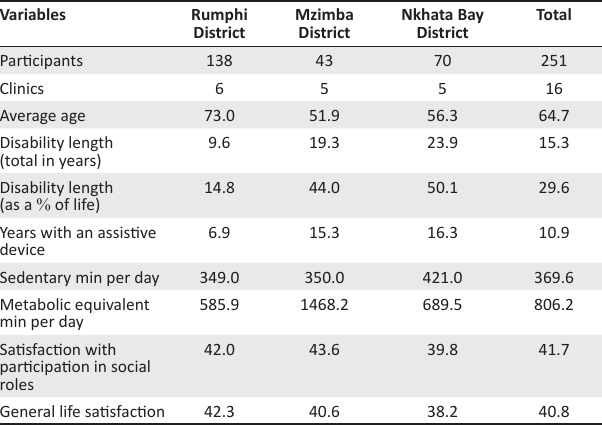
TABLE 1: Summary of demographics, state of disability, and life satisfaction in the sample population.